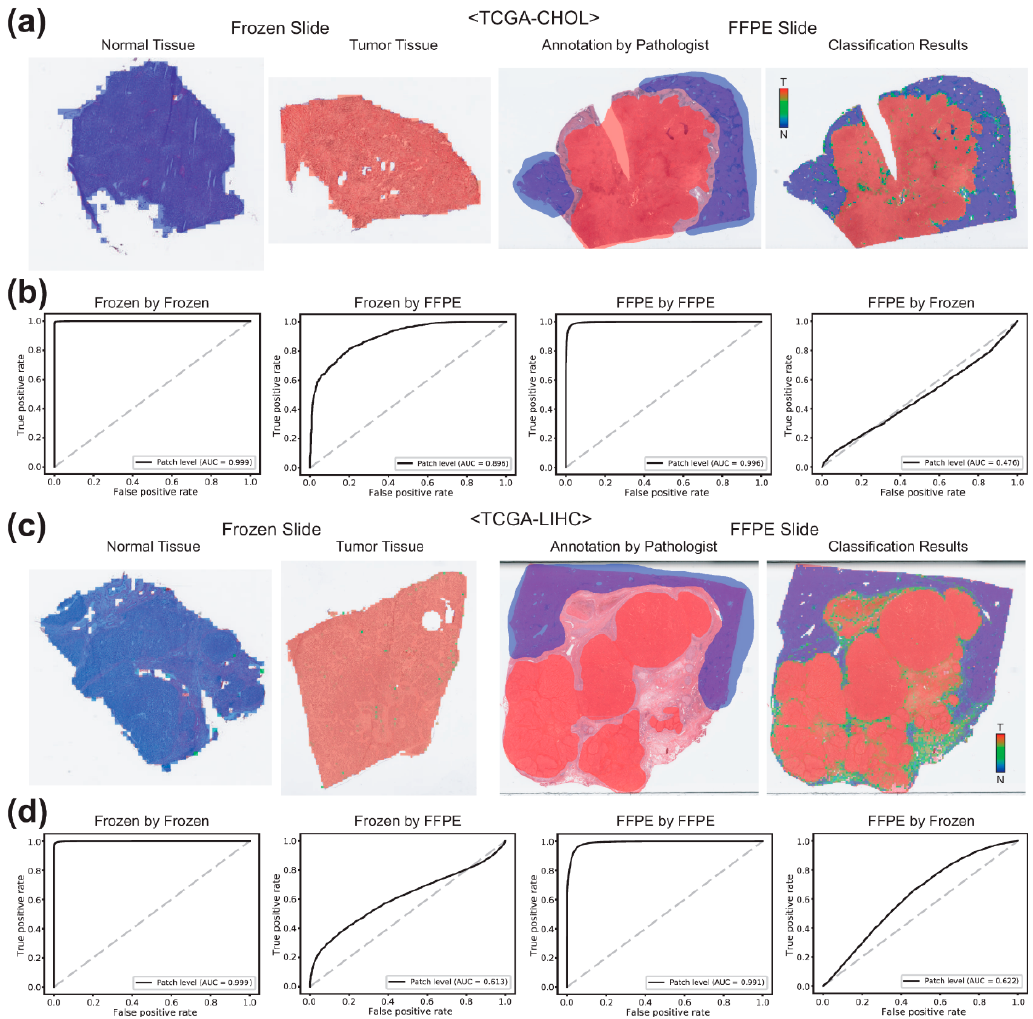
Figure 4. Classification results for the bile duct (TCGA-CHOL) and liver (TCGA-LIHC) datasets. ( a ) Representative classification results. Heatmaps were drawn for the representative whole slide images (WSIs) of the normal and tumor frozen WSIs of the TCGA-CHOL dataset (left two images). For a representative formalin-fixed paraffin-embedded (FFPE) WSI, both pathologists’ annotation and the heatmap result were presented for the comparison. ( b ) Receiver operating characteristic (ROC) curves for the classification results. Left two graphs: the ROC curves for the frozen tissues classified by the classifiers trained on frozen and FFPE tissues. Right two graphs: the ROC curves for the FFPE tissues classified by the classifiers trained on FFPE and frozen tissues. ( c , d ) are the same as ( a , b ), but the results were for the TCGA-LIHC dataset.